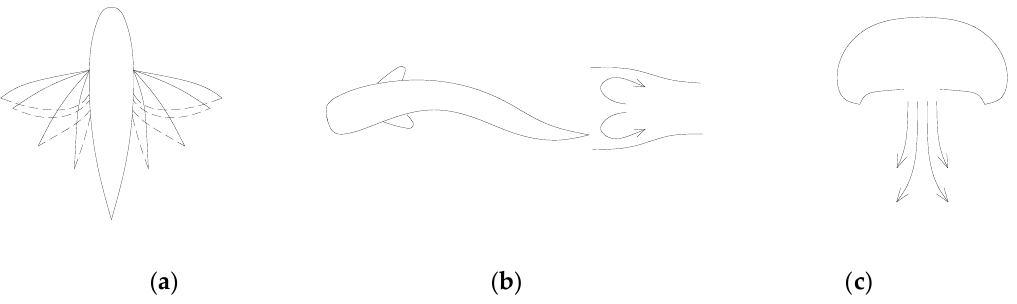
Figure 2. Main propulsion procedures from the view point of hydrodynamics; ( a ) Drag-based; ( b ) Added mass; ( c ) Momentum injection.